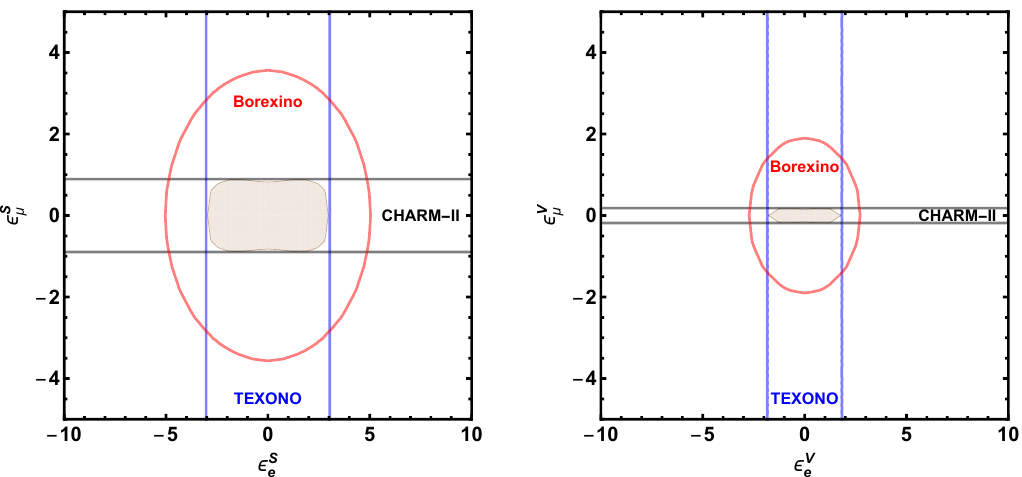
Figure 5 . The 90% CL allowed regions in the ( (cid:15) e , (cid:15) µ ) plane for the scalar (left panel) and vector (right panel) interactions. Here we assume m χ = 1 MeV and the coupling coefficients are real with (cid:15) τ = (cid:15) µ . The region enclosed by the black, blue and red curves correspond to the CHARM-II, TEXONO and Borexino experiments, respectively. The gray shaded regions correspond to the allowed regions of the combined data from these three